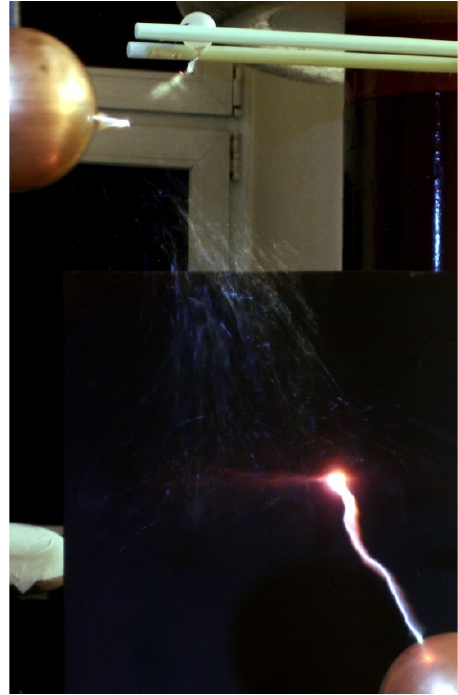
Figure 11. A simulated lightning strike in the lateral position of the electrodes around the flight train model (polarization positive, 8 s exposure).